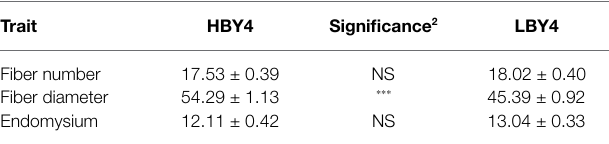
TABLE 2 | Line effects at d56 between the HBY4 and LBY4 lines 1 for histological analysis (Mean ± SEM). Trait